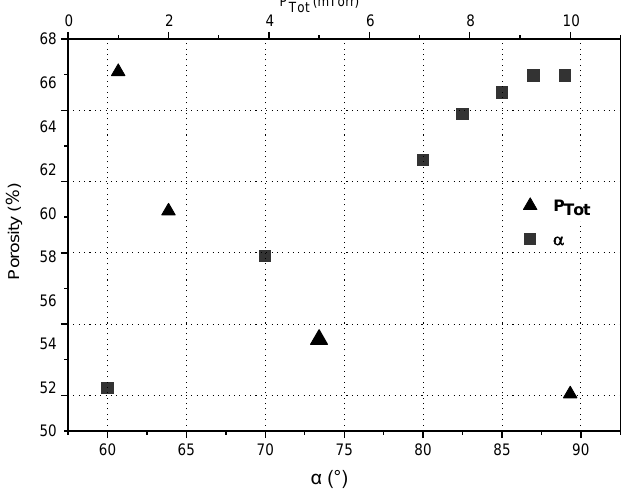
Figure 7. Evolution of the simulated values of the porosity as a function of the tilt angle, α , and of the working pressure, P Tot , for Mg nano-sculpted films prepared using a discharge power of 50 W.